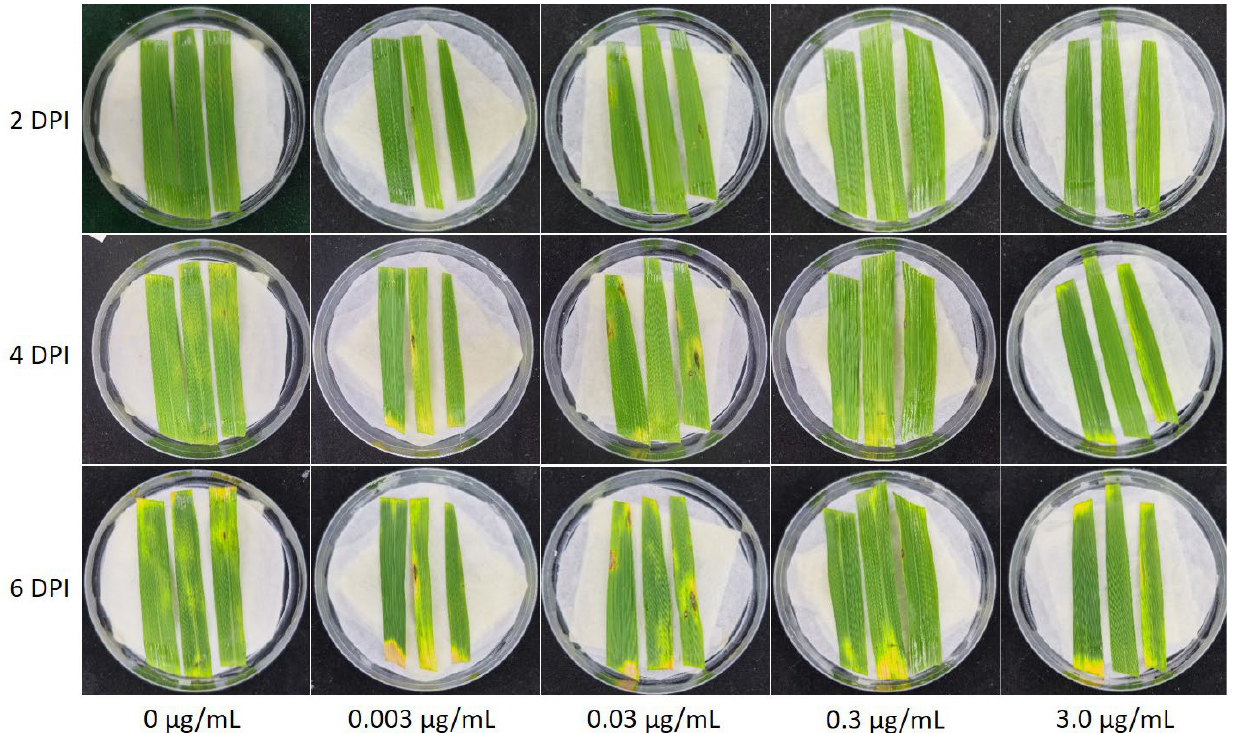
Figure 4. Time course of the infection process of conidia of Magnaporthe oryzae isolate Guy11 on detached rice leaves. Leaves were sprayed with carbendazim solutions at concentrations of 0, 0.003, 0.03, 0.3, and 3.0 μg/mL before inoculation of M. oryzae . DPI = days post inoculation.